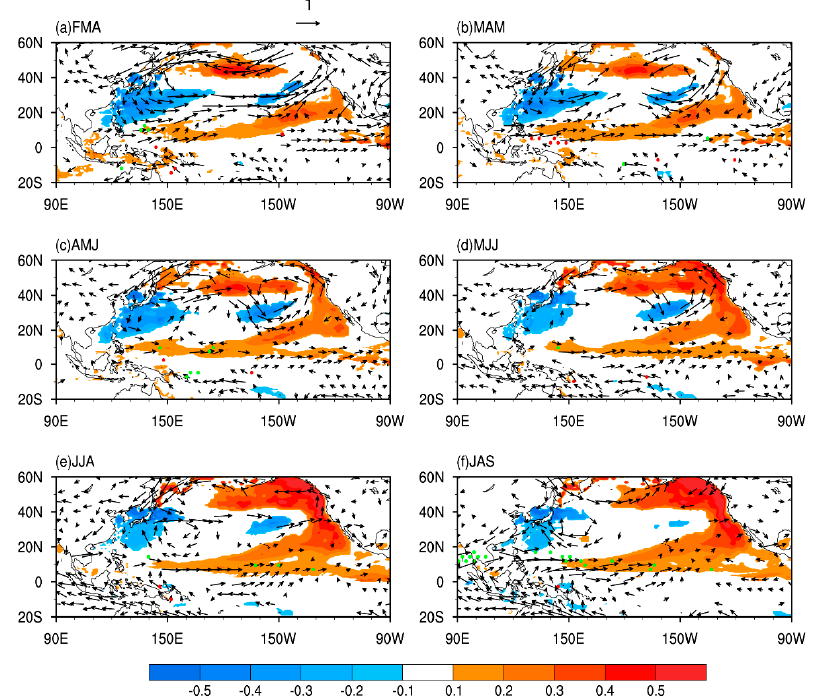
Figure 7. Composite differences in the seasonal evolution of SST (shading), wind vectors at 850 hPa (vector), and precipitation (stippled) anomalies between the forcing and control experiments for FMA ( a ), MAM ( b ), AMJ ( c ), MJJ ( d ), JJA ( e ), and JAS ( f ). Positive (red) and negative (blue) SST anomalies, significant at the 90% confidence level, are shaded. Positive (green) and negative (red) precipitation anomalies significant at the 90% confidence level are stippled. Only 850 hPa wind vectors significant at the 90% confidence level are shown.